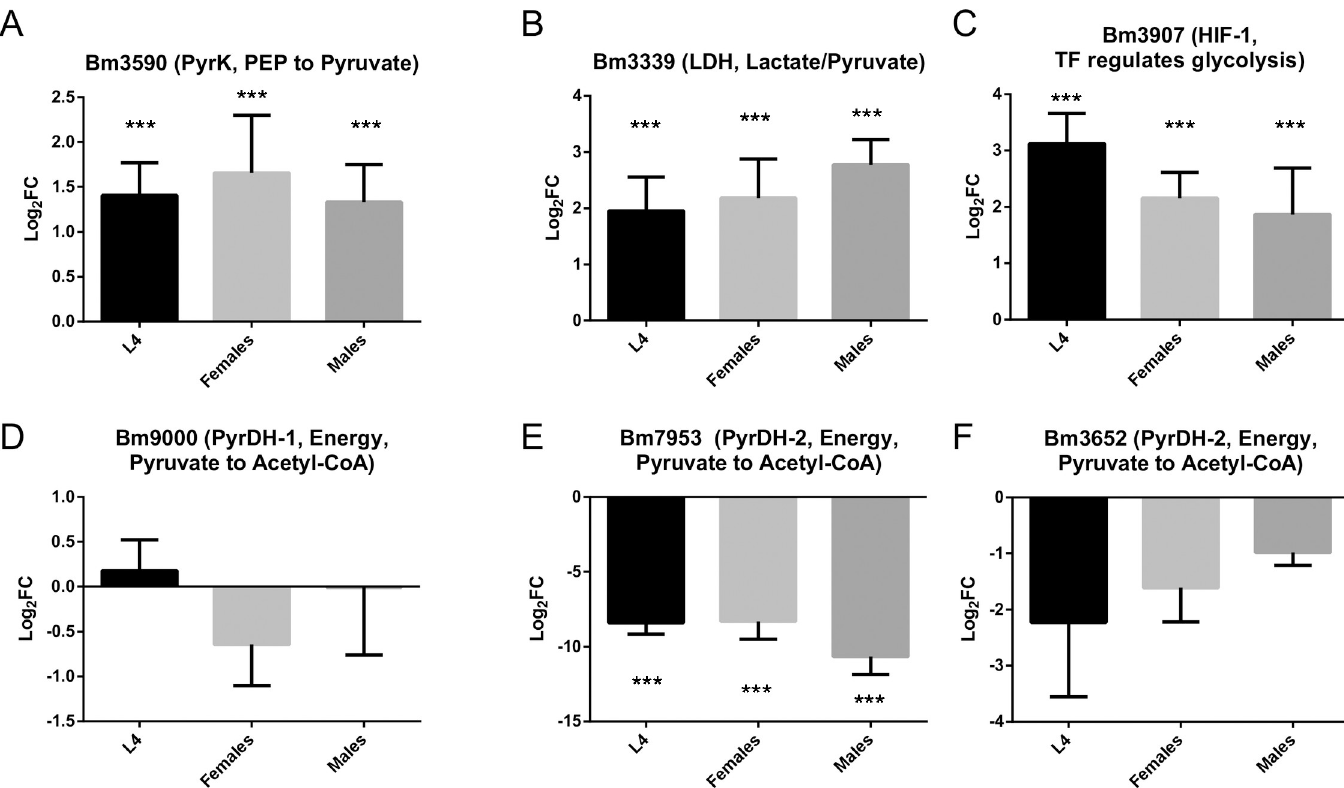
Fig 5. Analysis of transcriptomic data obtained from B . malayi L3, L4 and adult worms. A. Gene expression of PyrK (Bm3590) responsible for the final step in glycolysis (conversion of P-PEP to pyruvate). B. Gene expression of LDH (Bm3339) responsible for the conversion between lactate and pyruvate. C. Gene expression of HIF-1 (Bm3907), transcriptional factor that initiates the expression of glycolytic enzymes. D, E, F. Gene expression of PyrDH (Bm9000 (D), Bm7953 (E), Bm3652 (F)) responsible for the conversion of pyruvate to Acetyl-CoA. ��� –p < 0.001 as compared to L3